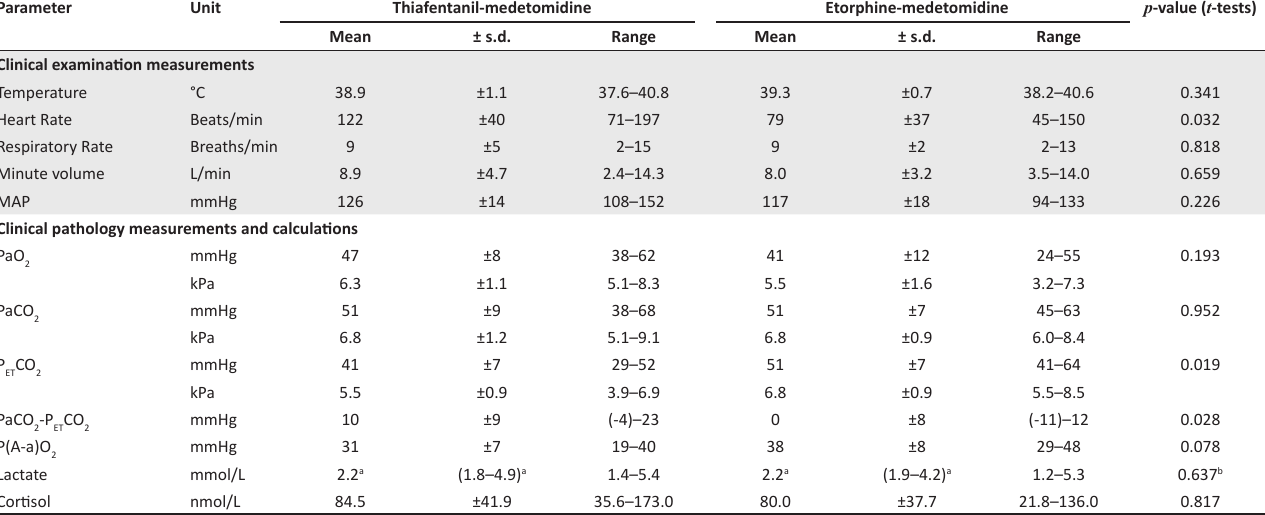
TABLE 1: Physiological variables obtained from impalas ( Aepyceros melampus ) immobilised with thiafentanil-medetomidine and etorphine-medetomidine combinations.